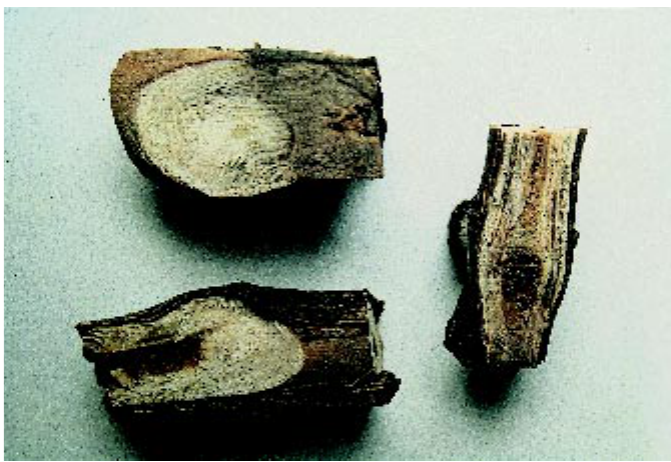
Fig. 5. Longitudinal section of the wood of a young plant with grapevine decline – the rotted wood is bordered by brown